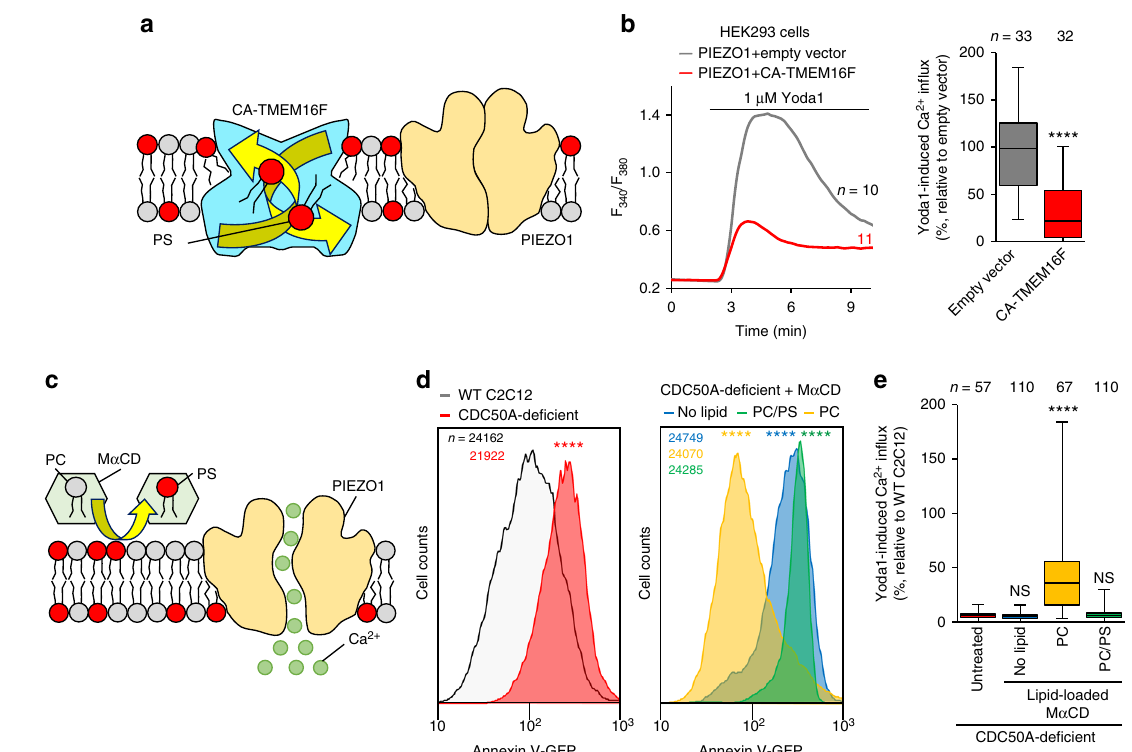
Fig. 5 Suppression of PIEZO1 activation by cell surface-exposed PS. a , b Suppression of agonist-induced PIEZO1 activation by overexpression of phospholipid scramblases. a Schematic illustration showing inhibition of PIEZO1 activation by CA-TMEM16-mediated bidirectional translocation of PS in the plasma membrane. b Representative traces (left) and quanti fi cation (right) of Yoda1-induced Ca 2 + in fl ux in HEK293 cells co-expressing PIEZO1 and CA-TMEM16F. c – e Rescue of agonist-induced PIEZO1 activation in PS fl ippase-de fi cient myoblasts by M α CD-catalyzed replacement of cell surface- exposed PS with exogenous PC. c Schematic illustration showing restoration of PIEZO1 activation by phospholipid exchange between PC-loaded M α CD and PS-exposing myoblasts. d , e Flow cytometry histograms of annexin V-GFP labelling ( d ) and quanti fi cation of Yoda1-induced Ca 2 + in fl ux ( e ) of CDC50A- de fi cient C2C12 myoblasts pre-incubated with no lipid-, PC/PS mixture (3:1)- or PC-loaded M α CD. **** P < 0.0001 (Student ’ s t -test). NS not signi fi cant, n sample number. Box and whiskers graph-line: median, box: upper and lower quartiles, whiskers: maxima and